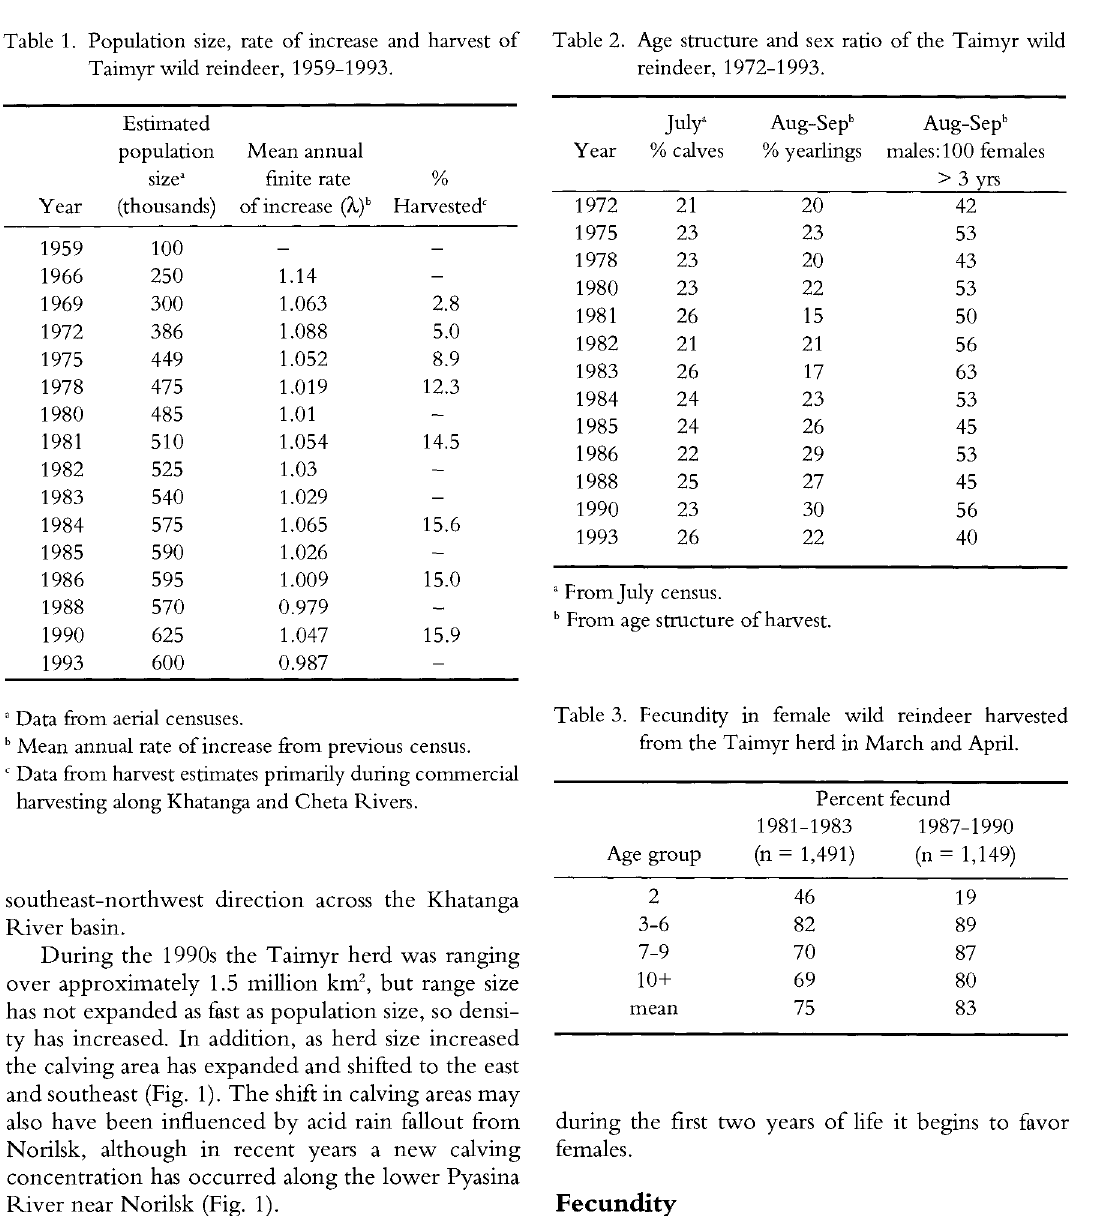
Table 1. Population size, rate of increase and harvest of Taimyr wild reindeer, 1959-1993.